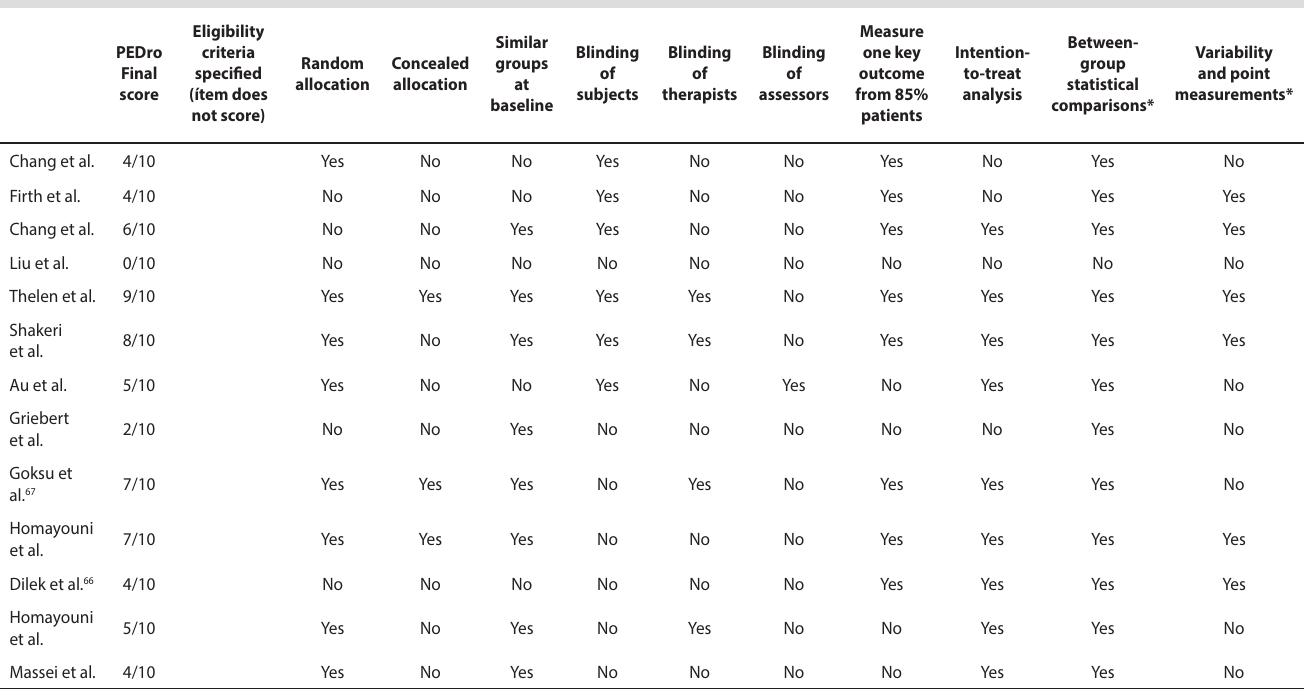
TABLE 3. PEDro Scale scores for selected